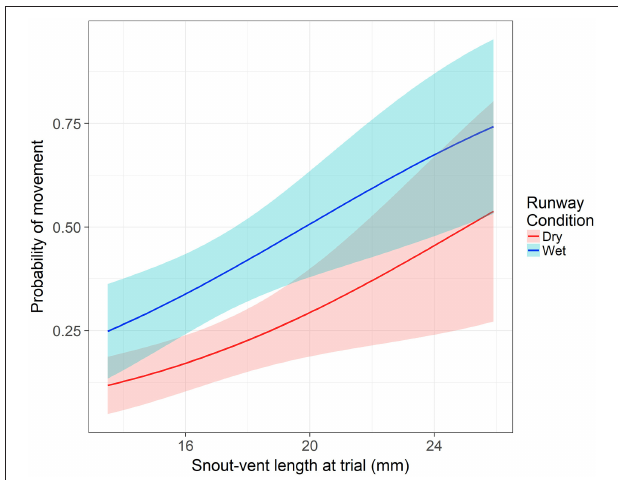
FIGURE 2 | The impact of snout-vent length and runway condition on probability of movement across the movement hurdle. Shaded areas represent the 95% confidence interval. Response is modeled off an individual from the permanent hydroperiod in their first runway assay with average body condition and time since metamorphosis.